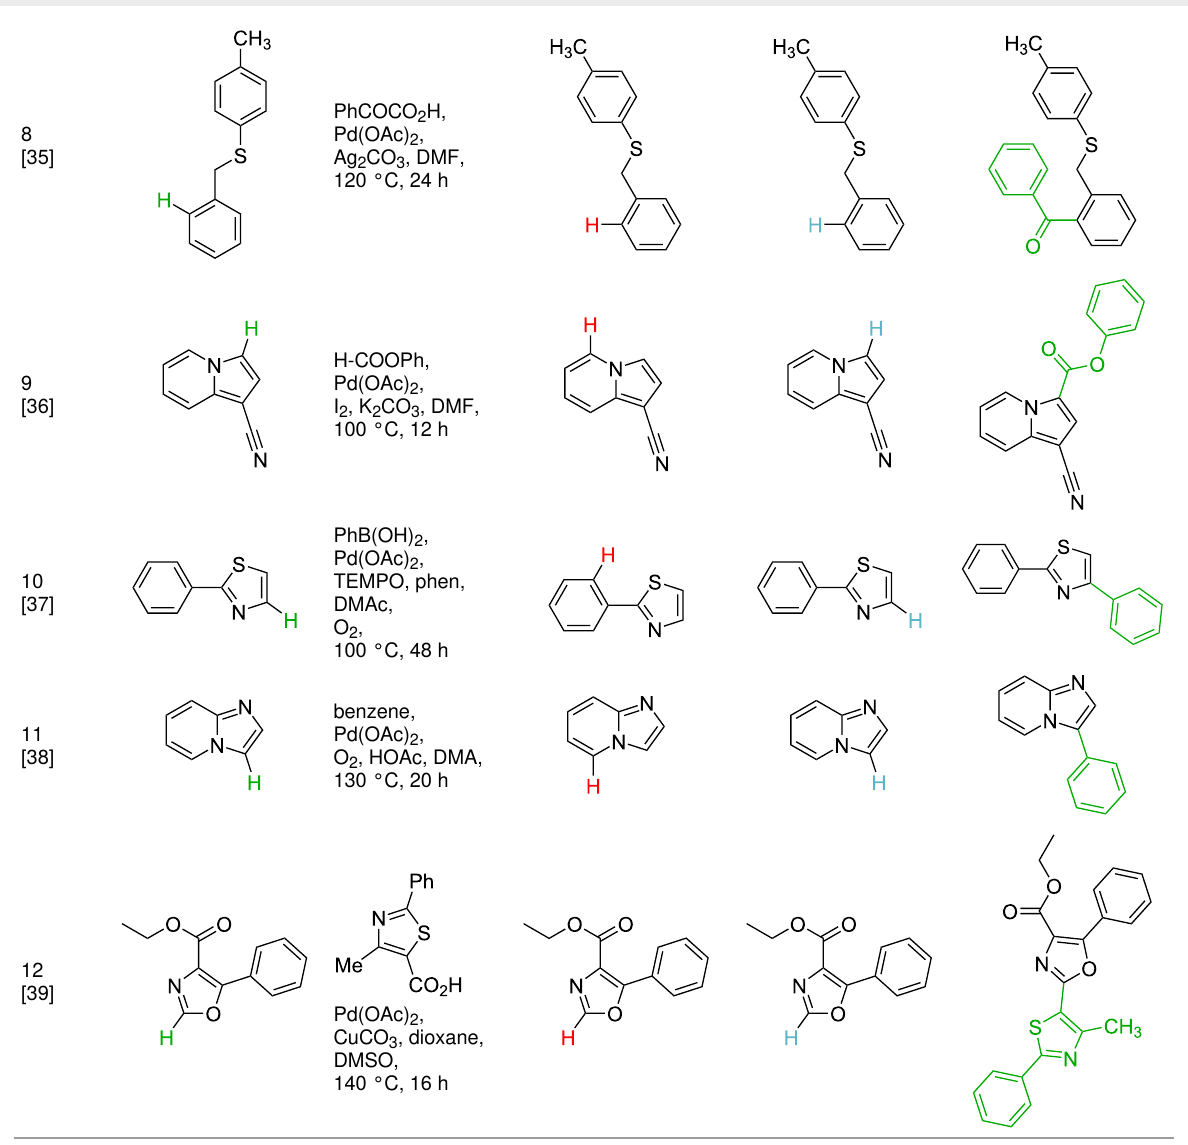
Table 1: Comparison of the published experimental results with the computational predictions for the Pd(OAc) 2 -catalysed reactions. a (continued)